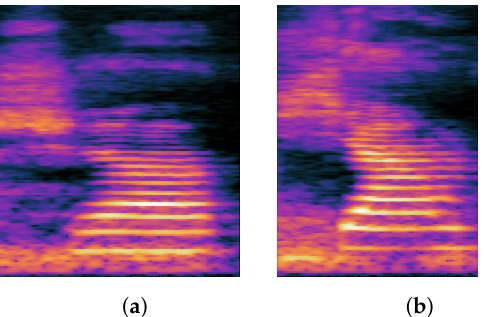
Figure 2. Spectrum comparison of backing and correct: ( a ) backing; ( b )